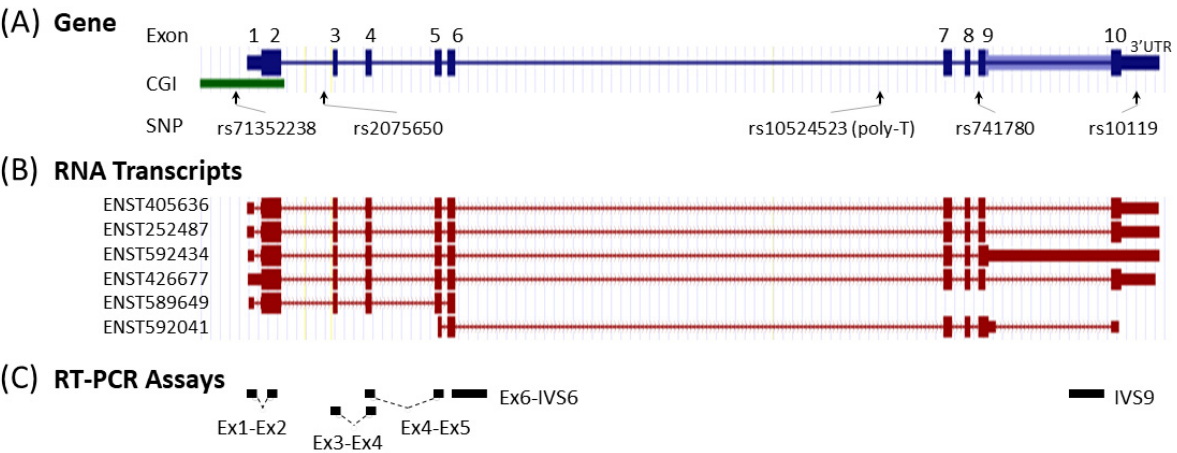
Figure 2. Map of the TOMM40 gene, RNA transcripts, and RT-PCR assays. ( A ) Structure and position of the exons, CpG island (CGI), and genetic variants (SNP). ( B ) Structure of the six mRNA transcripts defined by the Ensembl database. ( C ) Targets of the RT-PCR assays used in this study.